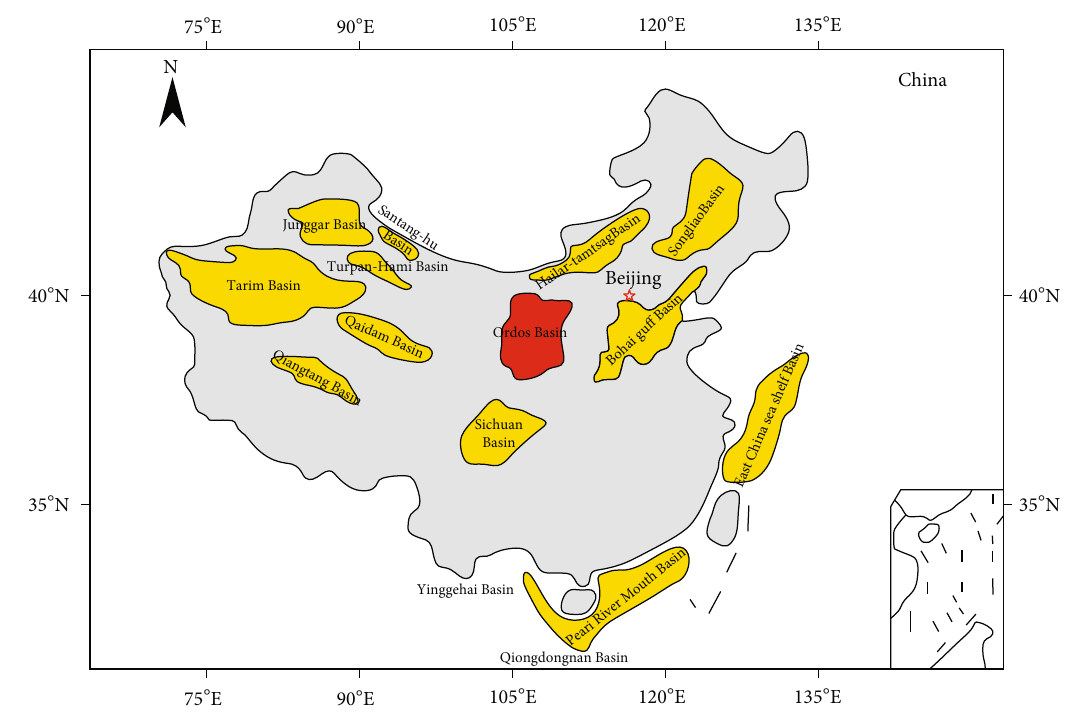
Figure 1: Regional overview of the Ordos Basin, China, and the location of the study